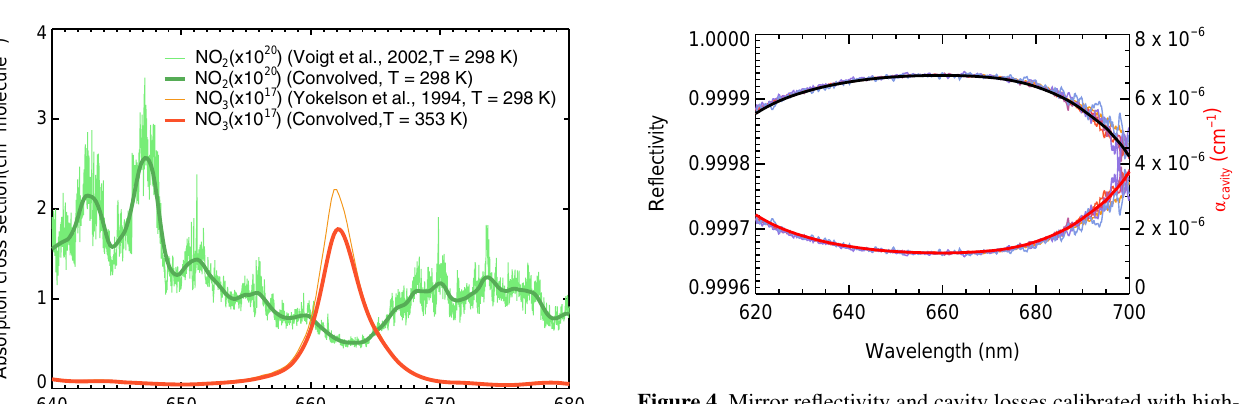
Figure 4. Mirror reflectivity and cavity losses calibrated with high- purity He and N 2 in the current experimental setup during the field measurements. The original calibration results were depicted by varying coloured lines: the smoothed black bold line is the aver- age R(λ) , and the smoothed bold red line is the average cavity loss ((1 − R(λ))/d ) from five measurements. The mean ( ± 1 σ) value at 662nm of reflectivity and the cavity loss are 0.999936 ± 0.000002 and (1.28 ± 0.01) × 10 − 6 , respectively. The effective path length at 662nm reached